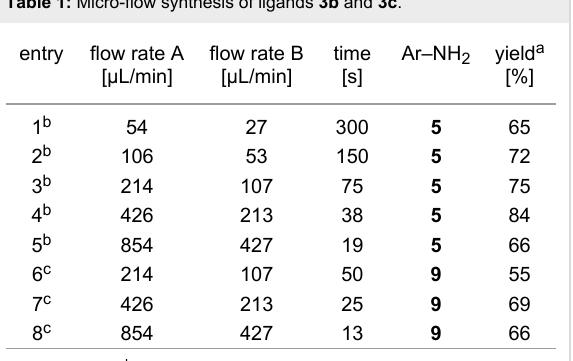
Table 1: Micro-flow synthesis of ligands 3b and 3c .